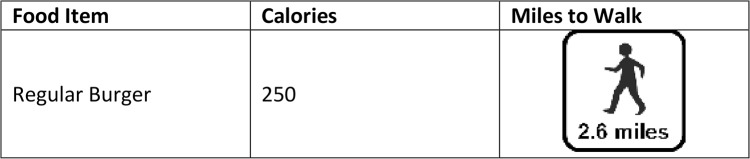
Sample PACE label for a regular burger conveys A.) Caloric content and B.) Miles needed to walk to burn off the calories in the regular burger.